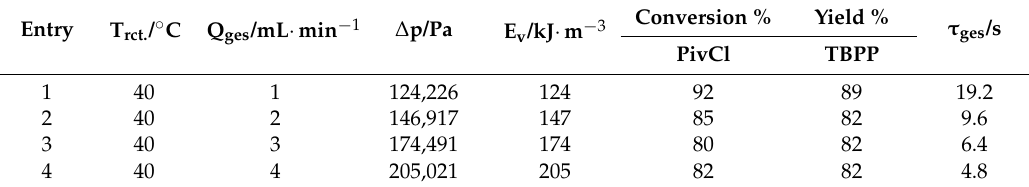
Table 4. Energy density at varying total flow rates by using the SAR reactor for TBPP synthesis at a reaction temperature of 40 °C.